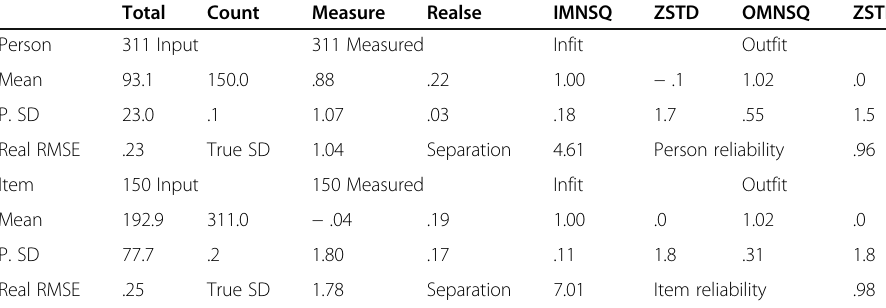
Table 1 Separation and reliability